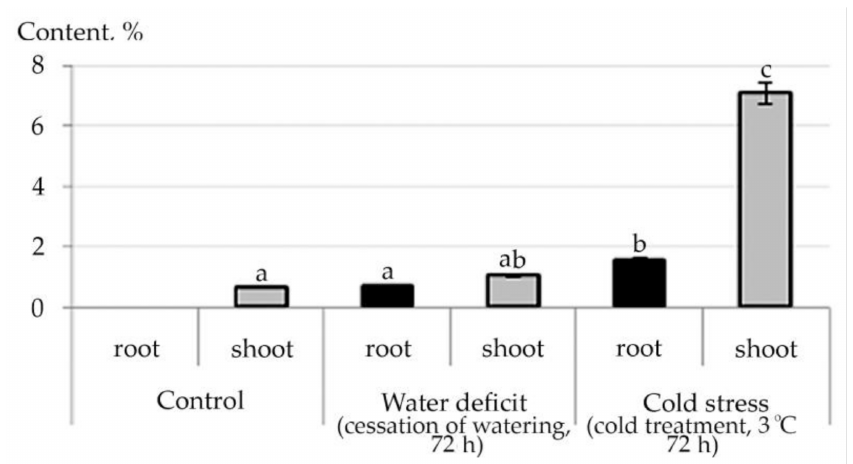
Figure 12. Change in concentration content of Diisooctyl phthalate (DIOP) in R. semenowii under stress conditions. Values presented are means ( ± SD). Different letters above the bars represent significant differences at p ≤ 0.05, n = 3 plants in each of 3 replicates for all treatments. A significant increase in the content of Phosphoric acid, diethyloctyl ester was shown under conditions of osmotic stress, and Phosphoric acid, diethylnonyl ester was found under conditions of cold stress in root (Supplementary Tables S1 and S2).